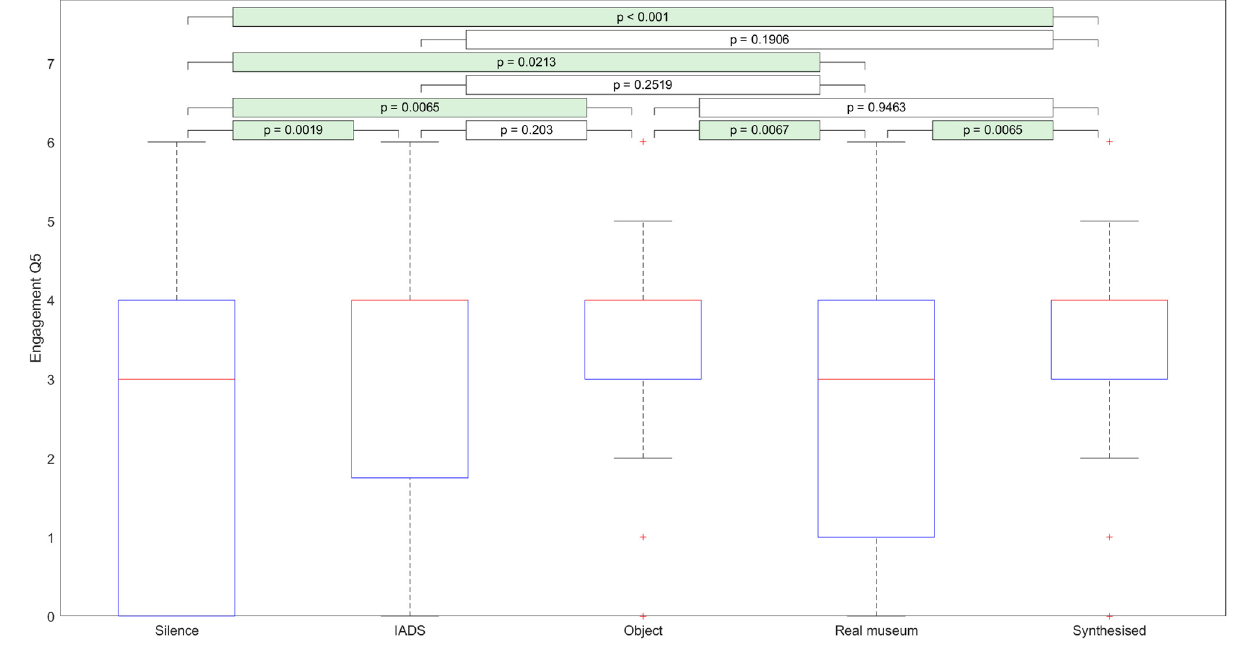
Fig 4. The effect of soundscape types on responses given to Engagement Q5.